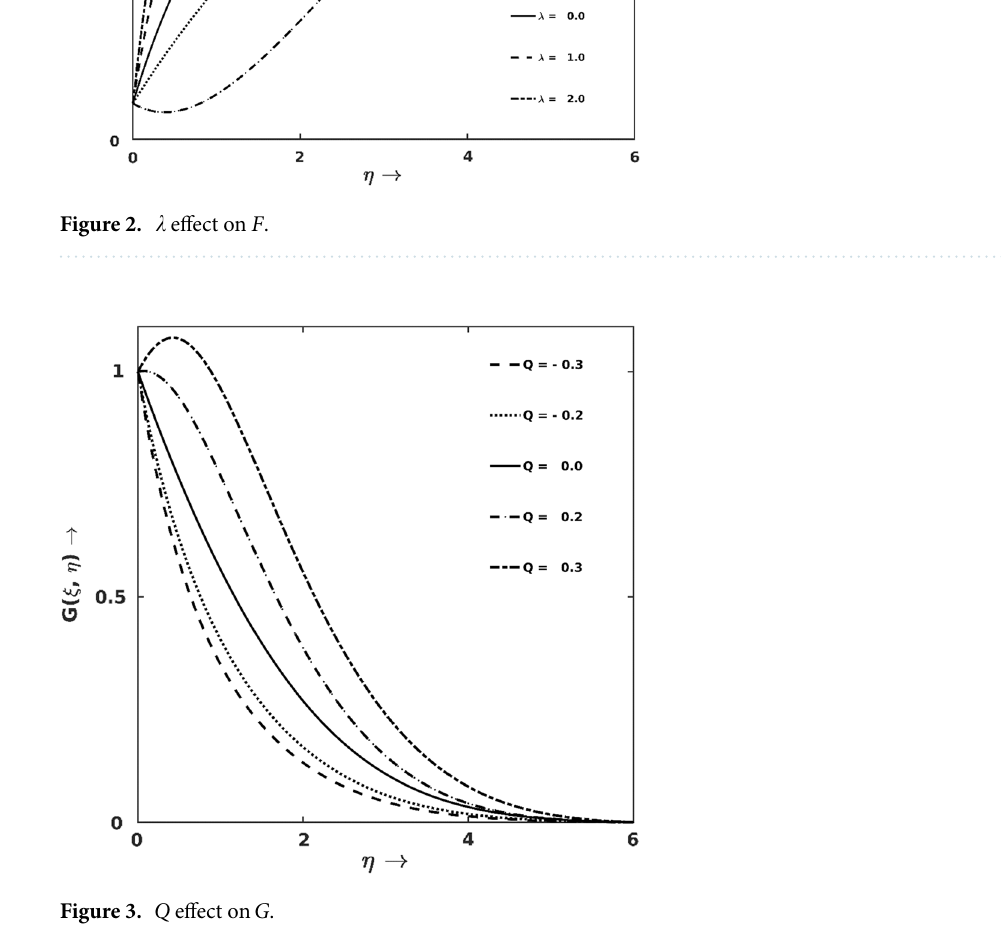
Figure 3. Q effect on G